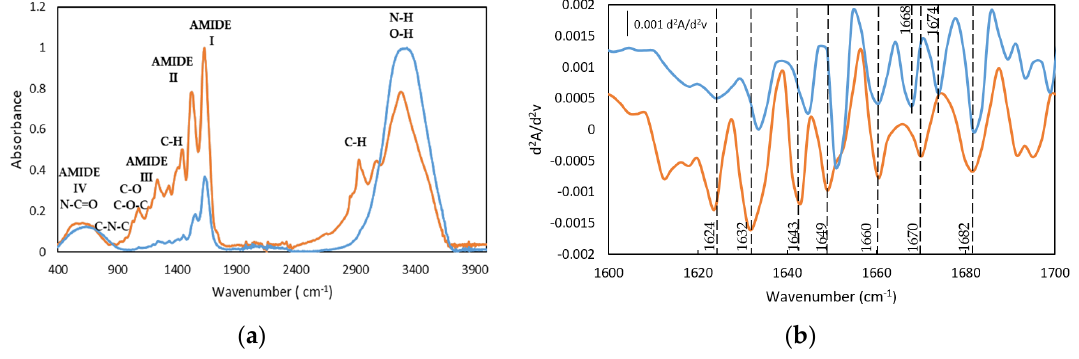
Figure 4. FTIR spectra ( a ) and spectra of the second derivative (differential FTIR spectra) in the absorption region of amide I by FDD method ( b ), of ( - ) Dry Tuna ( - ) Tuna gelatin hydrogel.